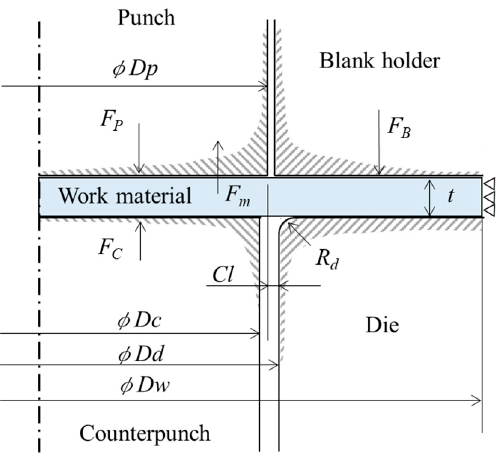
Figure 2. FEM simulation model. Table 1. FEM simulation